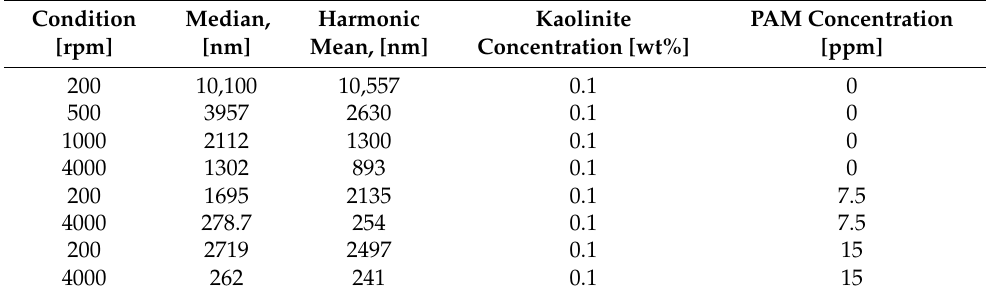
Table 3. Particle sizes were captured using LUMisizer software at fixed positions of 115, 120, and 125 mm along the height of the